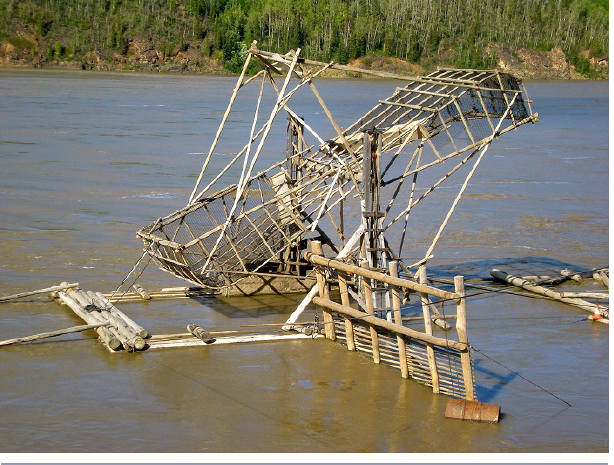
Fig. 5 . Fish wheel used by Yukon River fishers to catch king ( Oncorhynchus tshawytscha ) and chum ( O. keta ) salmon. Photo credit: K. Kielland, edited by: A.